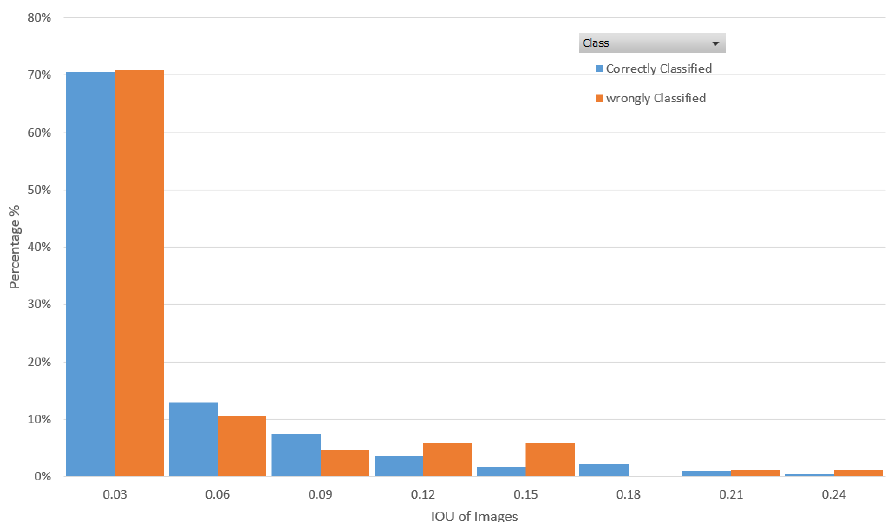
Figure 10. Normalized Histogram of IoU of network and lesion